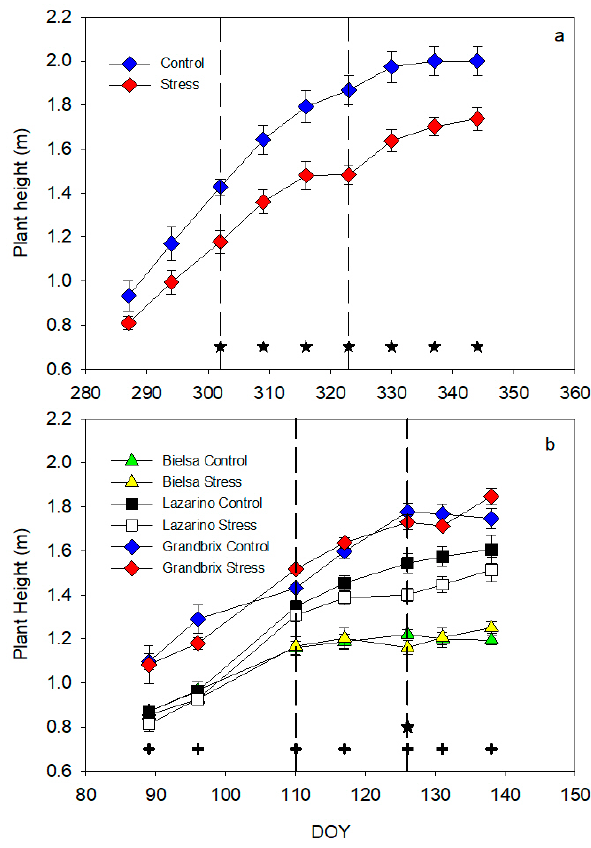
Figure 4. Pattern of plant height during the autumn ( a ) and spring ( b ) experiments. Each symbol is the average of 4 (autumn cycle) or 3 (spring cycle) data. Vertical bars represent the standard error. Vertical lines show the period of water stress. Asterisks (irrigation treatments) and crosses (cultivars) indicate the date when significant differences were found ( p < 0.05).